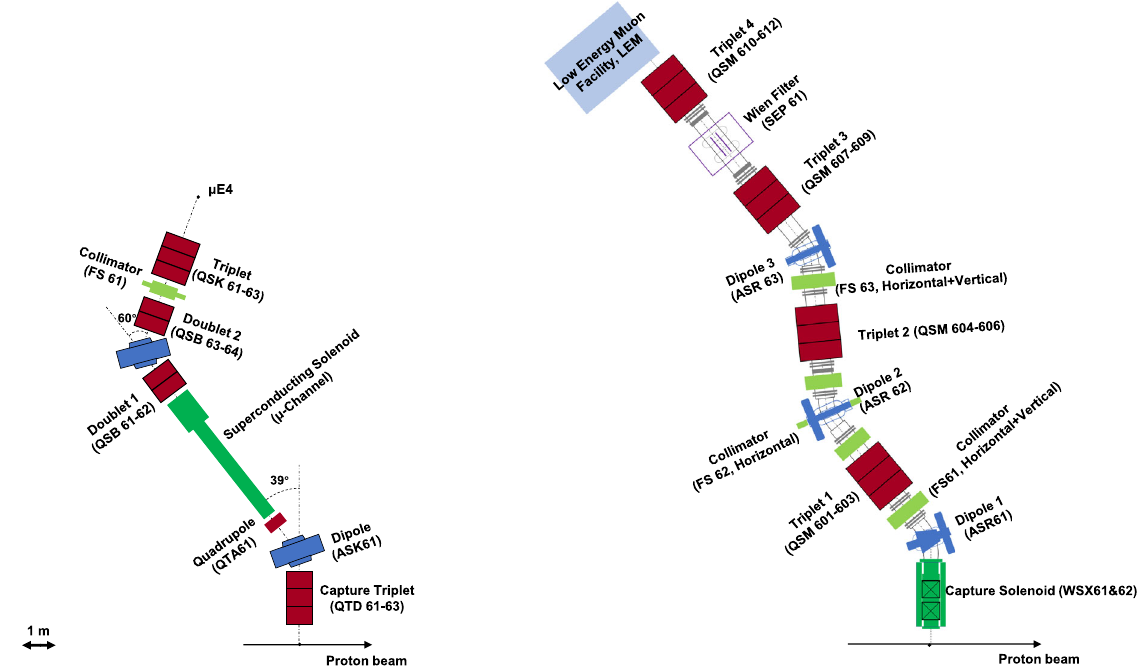
FIG. 1. Left: the old μ E 4 decay channel; Right: the hybrid-type μ E 4 beamline rebuilt in 2003 and 2004 as a surface muon injector for the LEM facility.